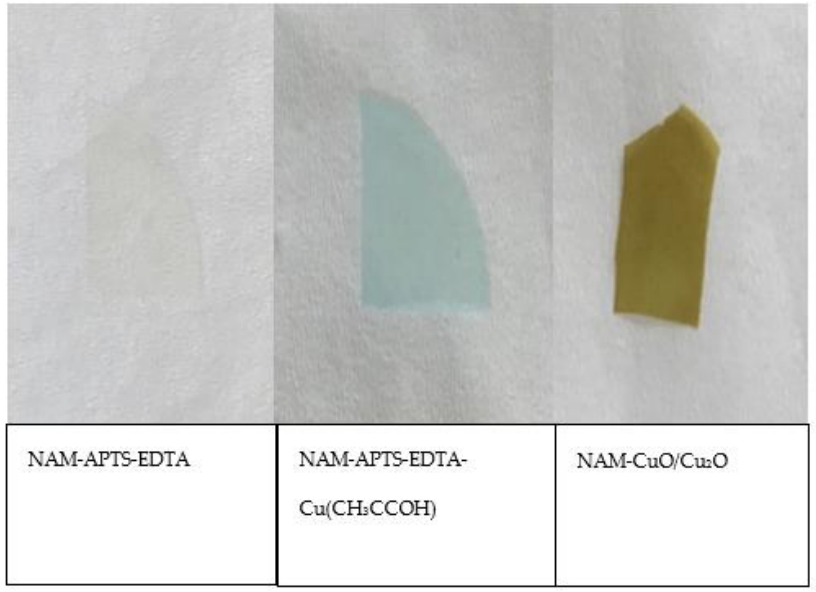
Figure 1. Digital images of the NAM-EDTAD, NAM-EDTA-Cu 2+ , and NAM-CuO/Cu 2 O membranes under normal white illumination.